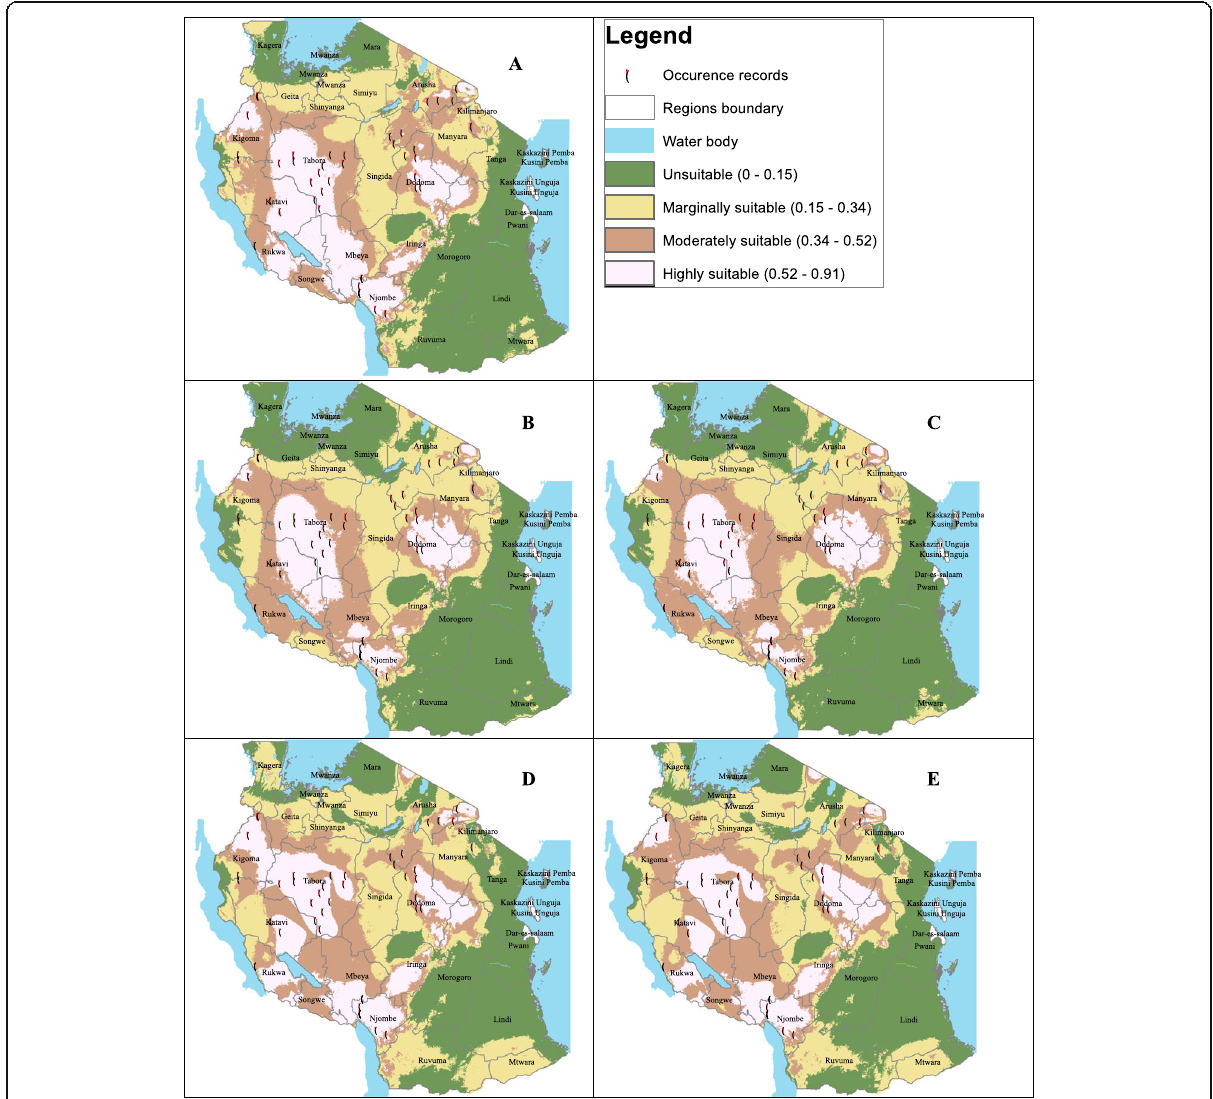
Fig. 3 Potential suitability areas for V. destructor in Tanzania. a Current scenario. b Mid-century rcp4.5 scenario. c Mid-century rcp8.5 scenario.